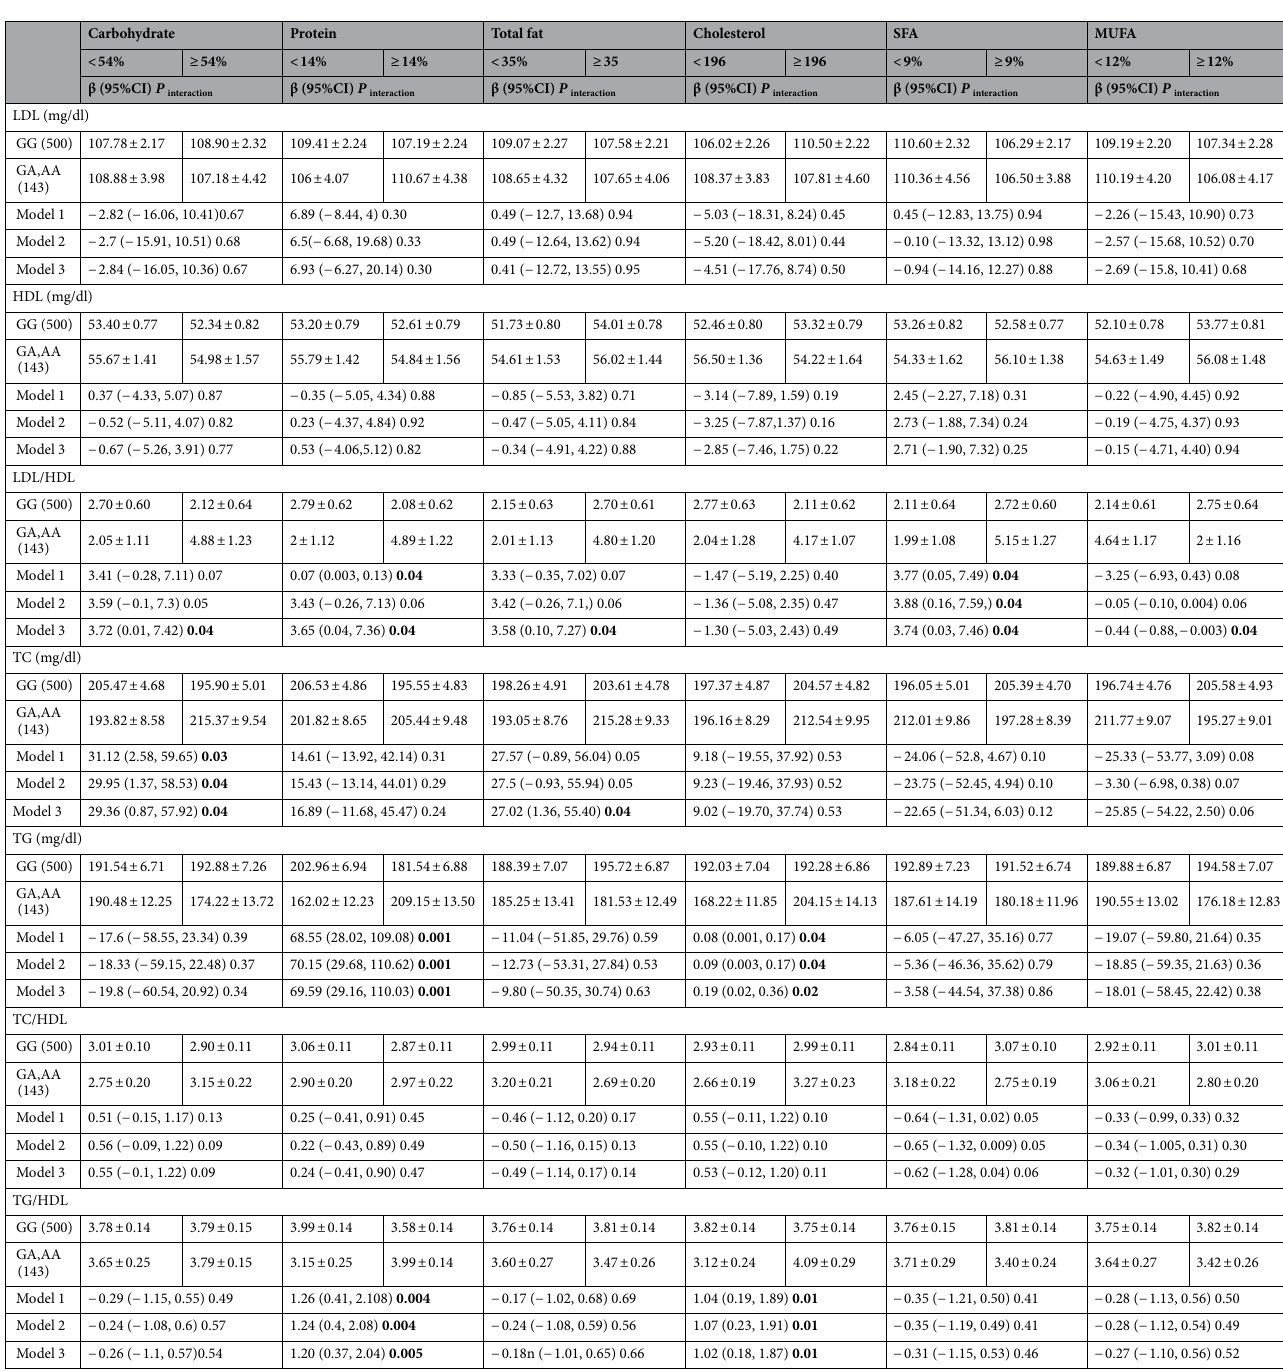
Table 3. Interactions of macronutrients intakes and ApoB EcoRI genotype on lipid profiles. CI confidence interval, TC total cholesterol, TG triglyceride, HDL high density lipoprotein, LDL low density lipoprotein. GG genotype is considered as a reference. Low median intakes of macronutrients considered as a reference. P values for the interaction obtained in multivariate models using GLMs. Model 1: unadjusted; Model 2: adjusted for age, gender, physical activity, alcohol consumption and lipid-lowering medications; model 3: adjusted for variables in model 2 plus for smoking, total energy intakes and fiber